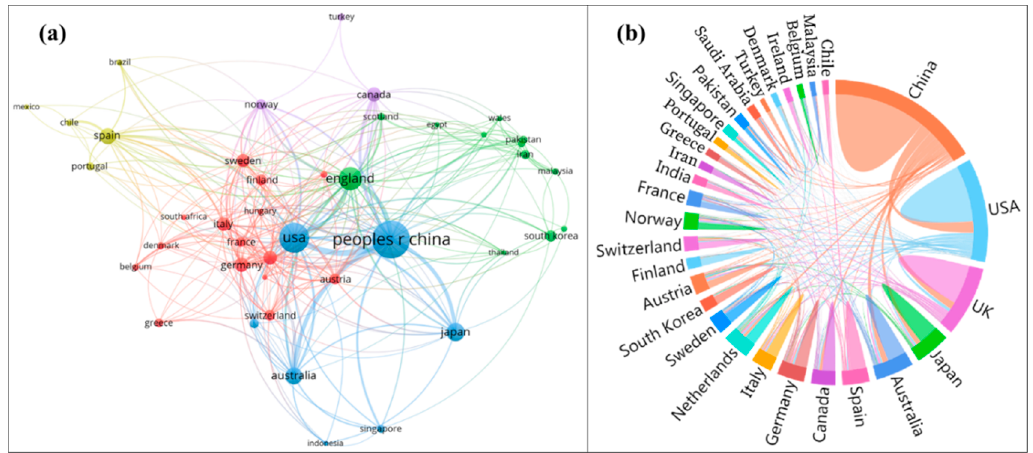
Figure 3. National cooperation network maps for HCEs research from 1991 to 2020. ( a ) Co–authorship among countries; ( b ) cooperation among top 30 countries/territories.